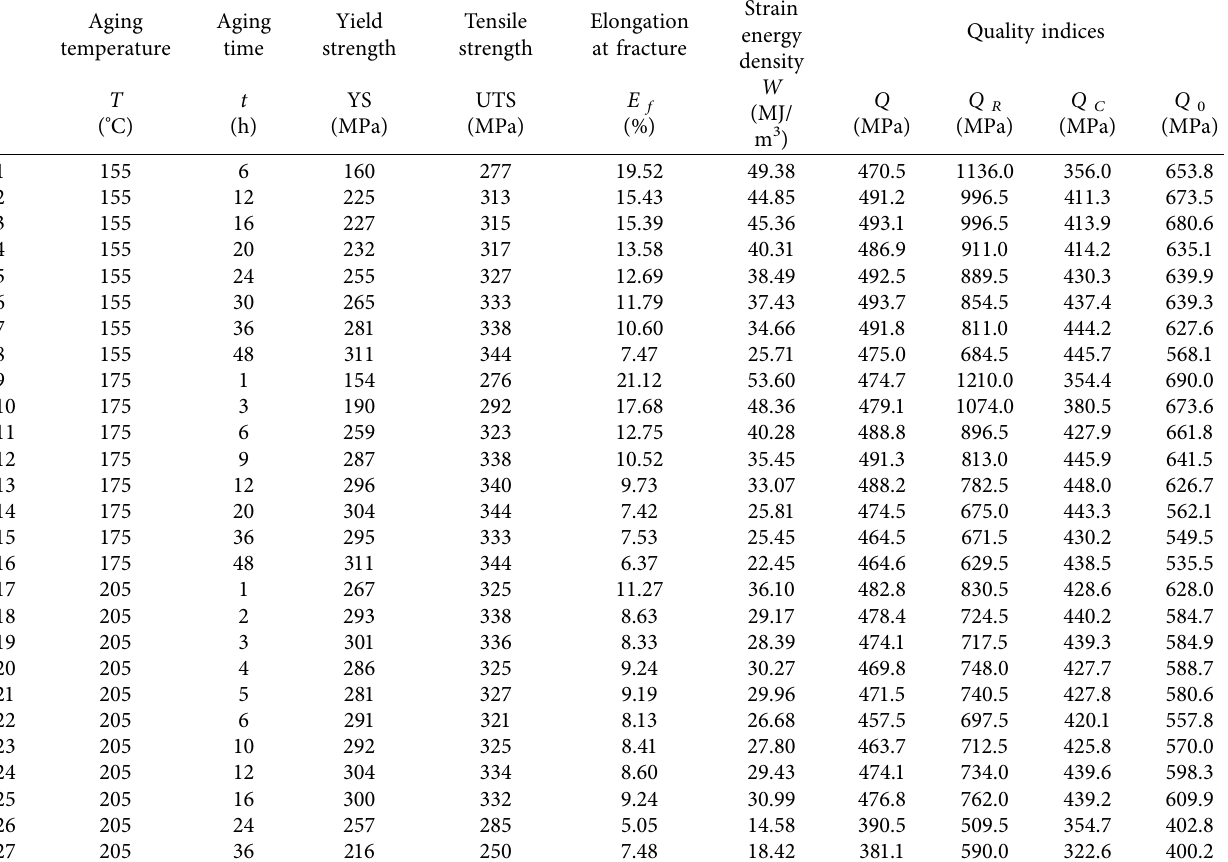
Table 1: Mean values of the tensile mechanical properties and quality indices of cast aluminum alloy A357 according to 27 diferent artifcial aging heat treatment conditions [2,